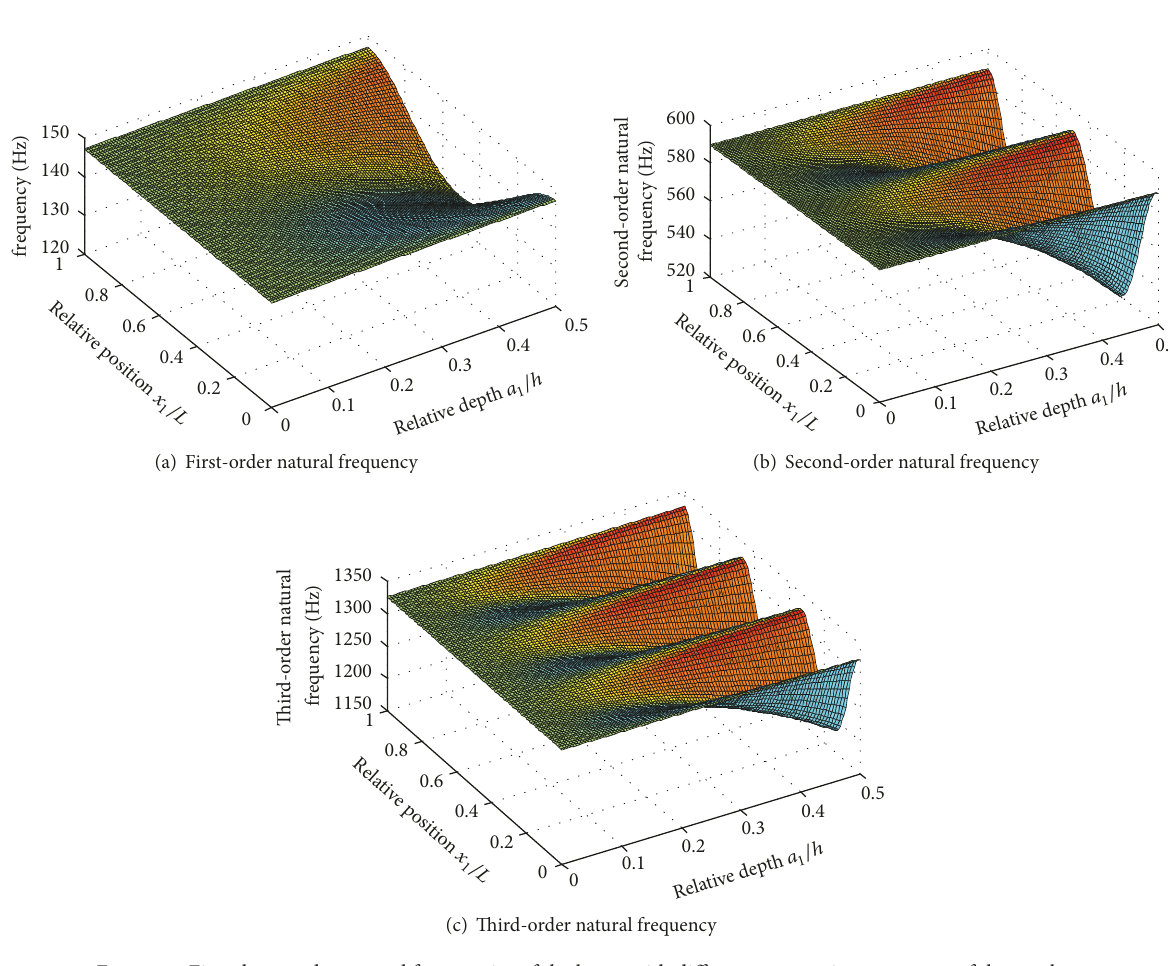
Figure 7: First three-order natural frequencies of the beam with different geometric parameters of the